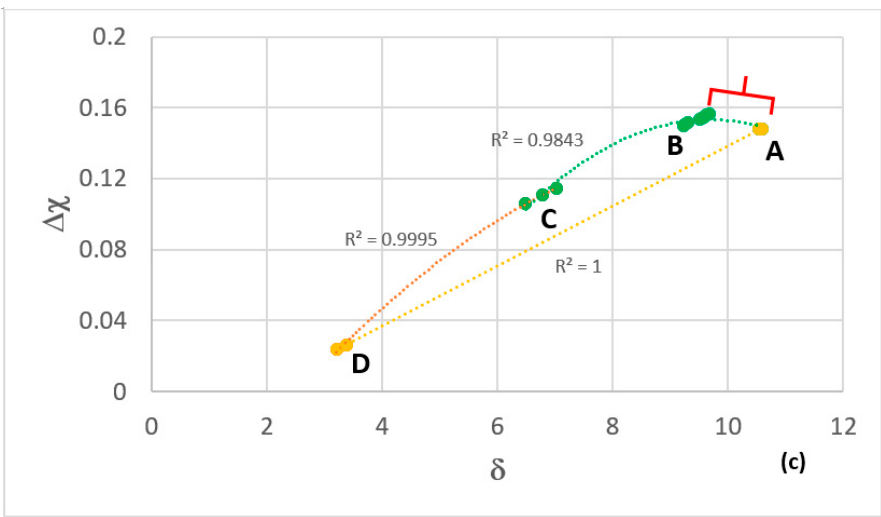
Figure 13. Maps of the parameters δ , Δχ , and VEC with data for the alloys OHC5, MG5, MG6, MG7, Zone A of MG7, and OHC3, see also text, Table 2, and Figure 11. In the maps, area A corresponds to OHC5, B to MG5, MG6, MG7, C to Zone A of MG7, and D to OHC3. The microstructures in different areas of the maps and the “direction” of increase in Al concentration, mass change per unit area ( Δ w), and oxide thickness (d) are shown in (a) . The area where alloys could be considered as High Entropy Alloys (HEA) or Complex Concentrated Alloys (CCA) and the “direction” of increase of Si concentration in the map are shown in (b) . The area where the oxidation rates of alloys are in the range of NiAl and Ni-Cr-Al alloys at 1200 °C is shown by the red brackets in (b) and (c) . Notice parity of colours with Figure 11. Table 2. Comparison of the alloys OHC3, OHC5, MG5, MG6, and MG7, see also Figure 13. Figure Phases (AC Alloy Alloying elements (at %) MAP and HT) [ref] area